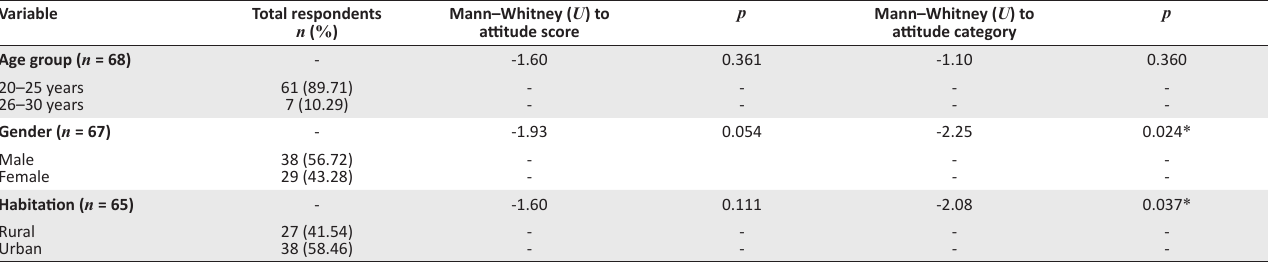
TABLE 1: Demographics associated with attitude score and attitude categories ( n = 70). Variable Total respondents n ( % )